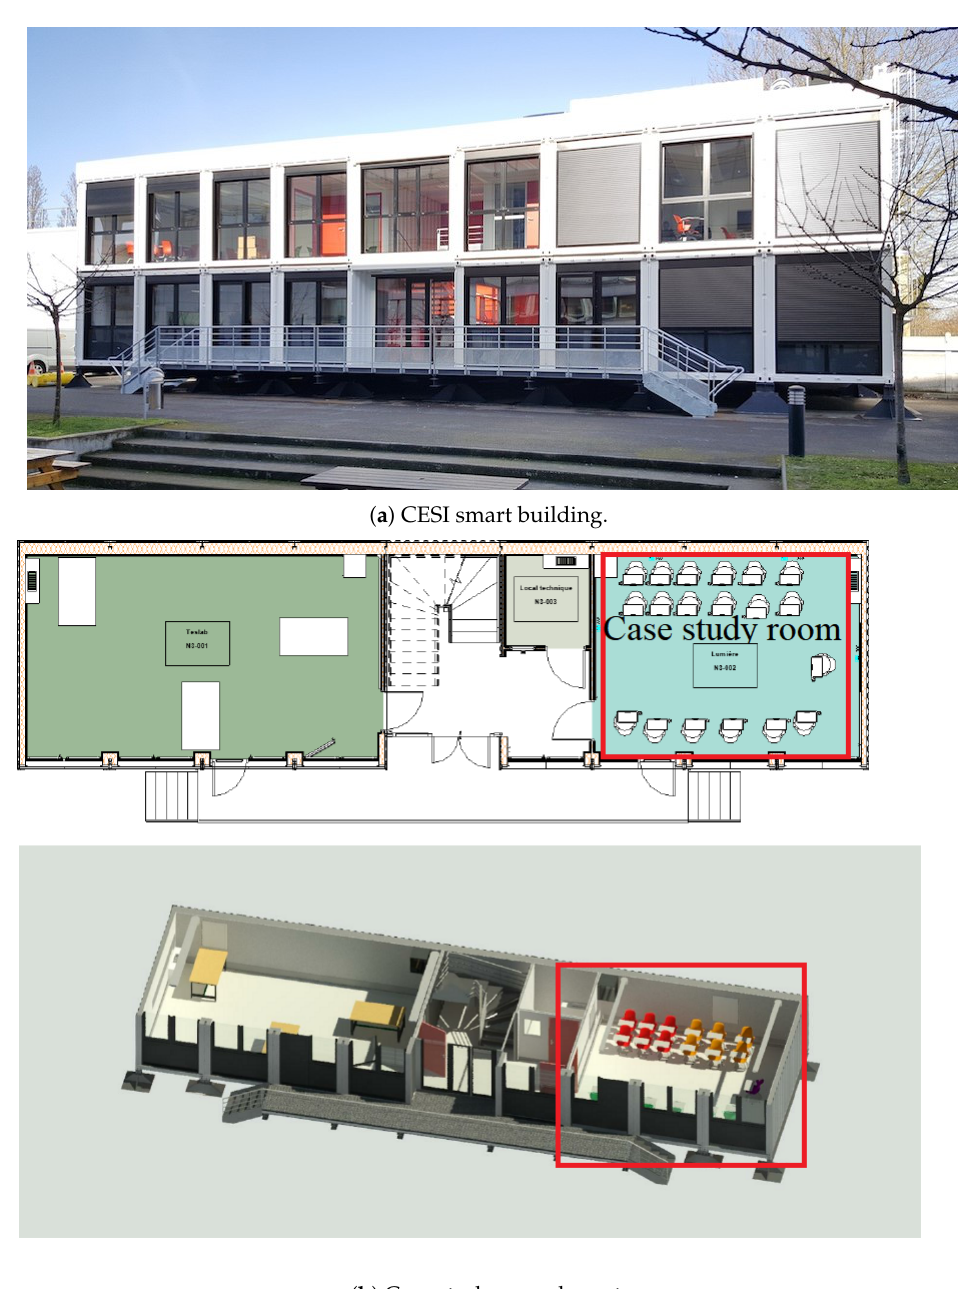
Figure 8. CESI smart building and the case study